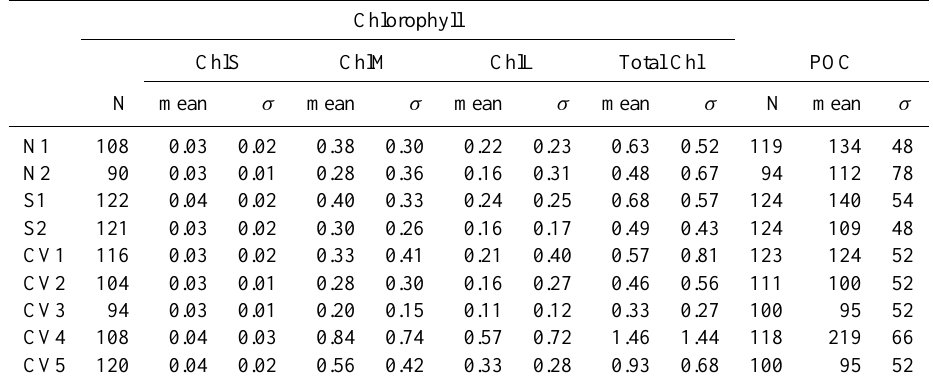
Table 2. Number of observations (N), mean and standard deviation ( σ ) of the satellite-derived chlorophyll concentrations (small, medium, large and total; mgChlm − 3 ) and POC data (mgCm − 3 ) at each site. Chlorophyll ChlS